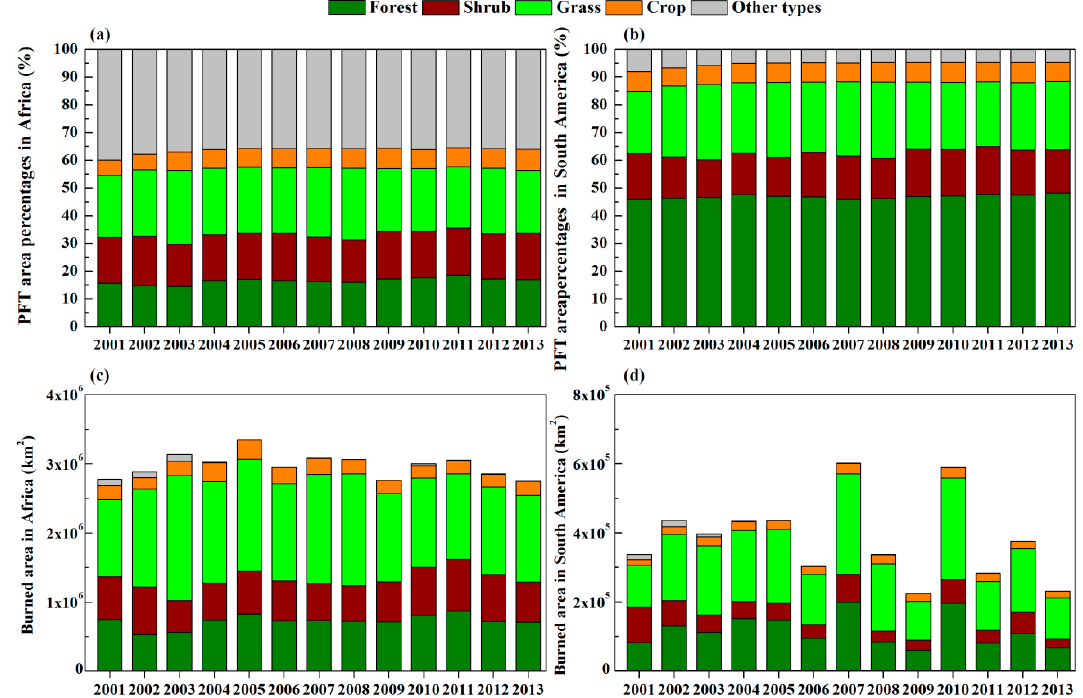
Figure 2. The area percentages of each vegetation type in Africa ( a ) and South America ( b ); the burned area stratified by land cover in Africa ( c ) and South America ( d ) from 2001-2013.